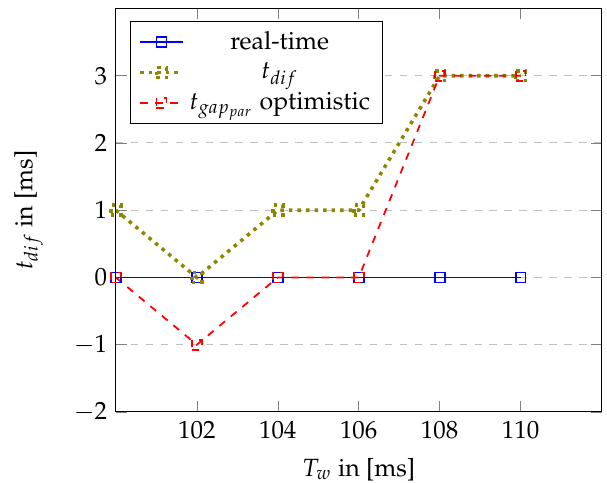
Figure 8. t gap for optimistic simulation par